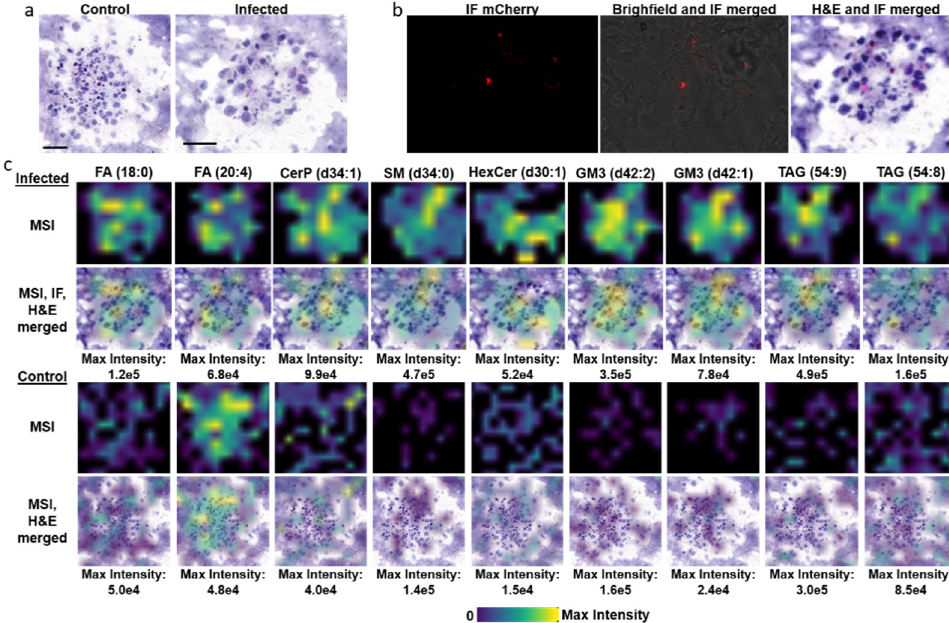
Figure 3. Mass spectrometry imaging (MSI) of TB spheroids detects lipidomic alterations that correlate with human TB and animal models of infection. ( a ) Hematoxylin and Eosin (H&E) stained spheroids treated with PMA used for MSI. ( b ) Immunofluorescence (IF) of the mCherry BCG infected spheroid (left panel), brightfield and IF merged image (middle panel), IF of mCherry BCG and the corresponding H&E of the same spheroid. ( c ) MSI data of lipids detected in infected vs. control spheroids (top panels). MSI lipid data overlaid with the IF-H&E merged images correlating lipid data with cell infection status (bottom panel of infected spheroids). MSI lipid data detected in control spheroids overlaid its corresponding H&E section (bottom panel). FA, fatty acid; CerP, ceramide-1-phosphate, SM, sphingomyelin; HexCer, hexosylceramides; GM3, monosialodihexosylganglioside; TAG, triacylglyceride. The scale bars are each 100